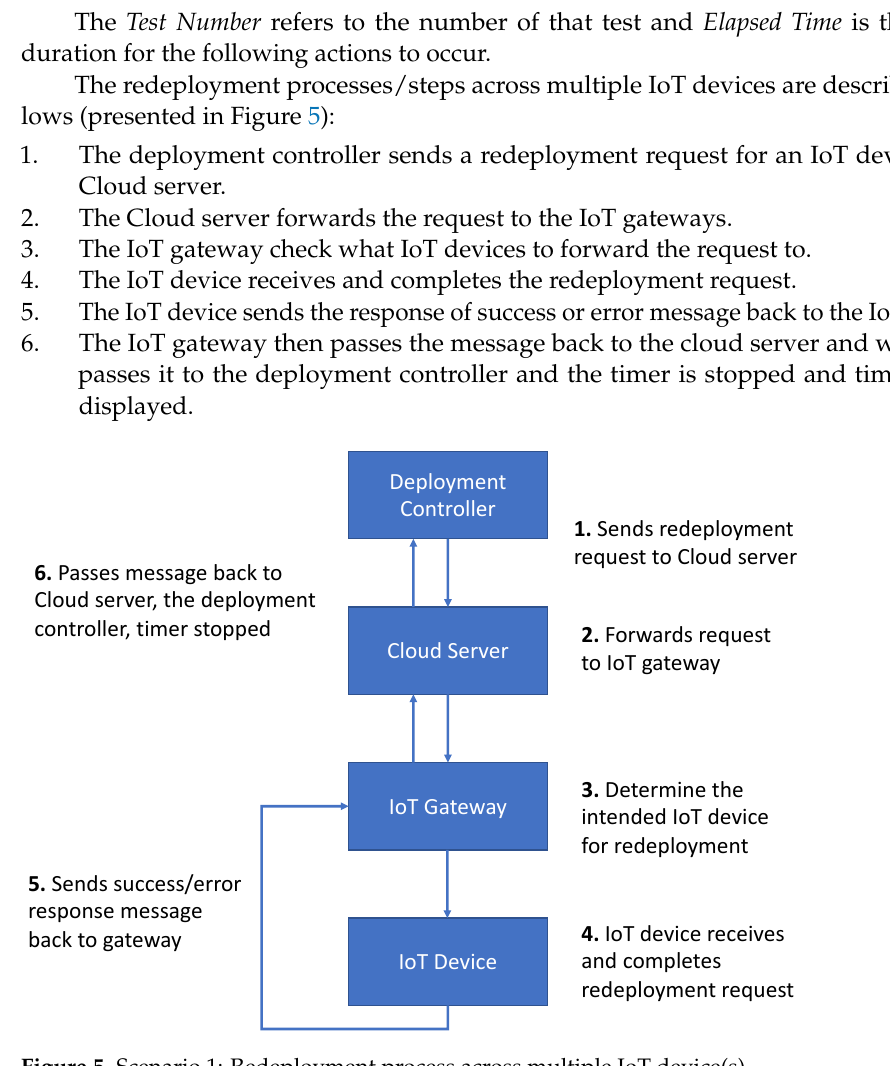
Figure 5. Scenario 1: Redeployment process across multiple IoT